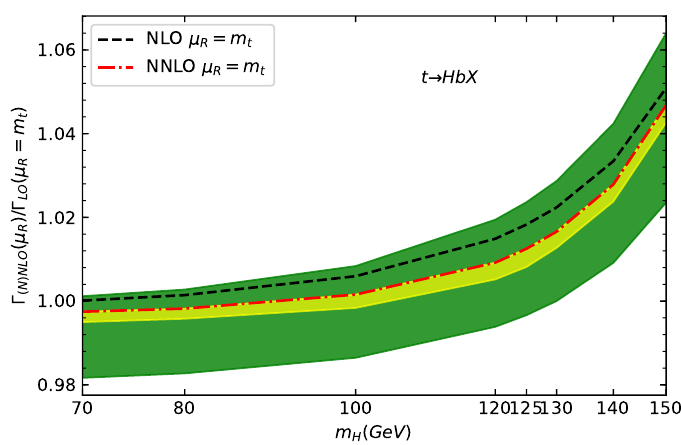
Figure 6. The NLO (dashed black line) and NNLO (dot-dashed red line) partial decay width of top quark decaying into a charged Higgs boson and jets for different charged Higgs boson masses. The green (yellow) band is bounded by the maximum and minimum of NLO (NNLO) partial width at three renormalization scales µ R = 1 m t , m t , 2 m t . All the results are normalized to the LO partial 2 width at µ R = m t